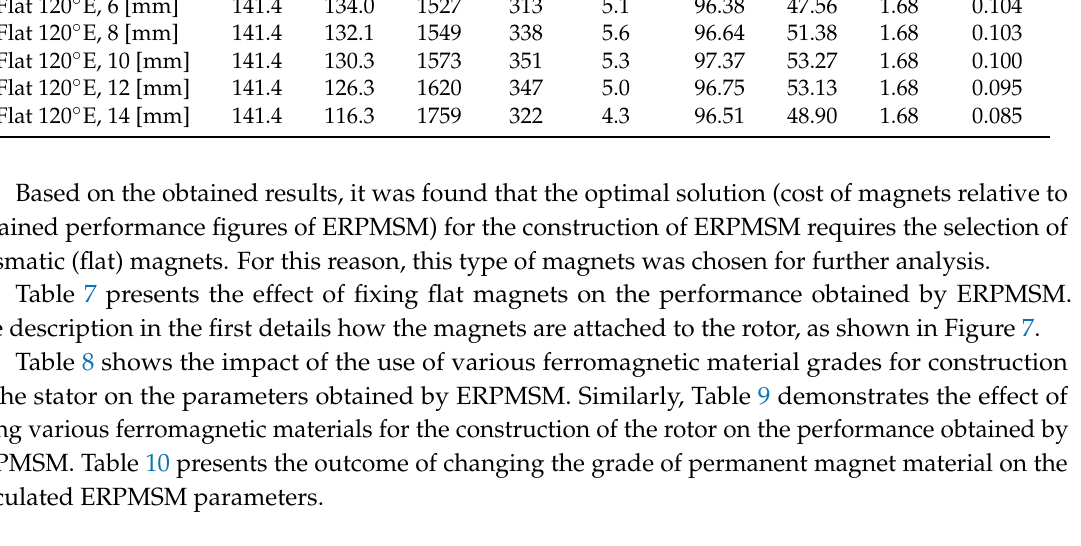
Table 6. The effect of thickness changes of prismatic magnets on the obtained ERPMSM parameters.